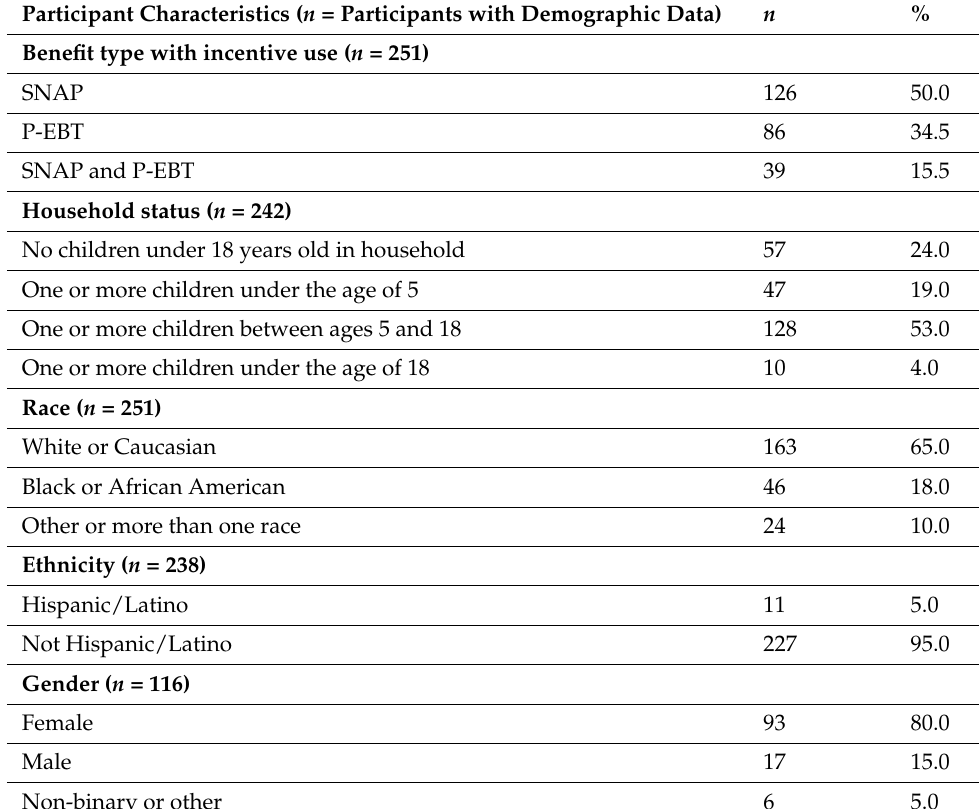
Table 1. Virginia Fresh Match incentive participant